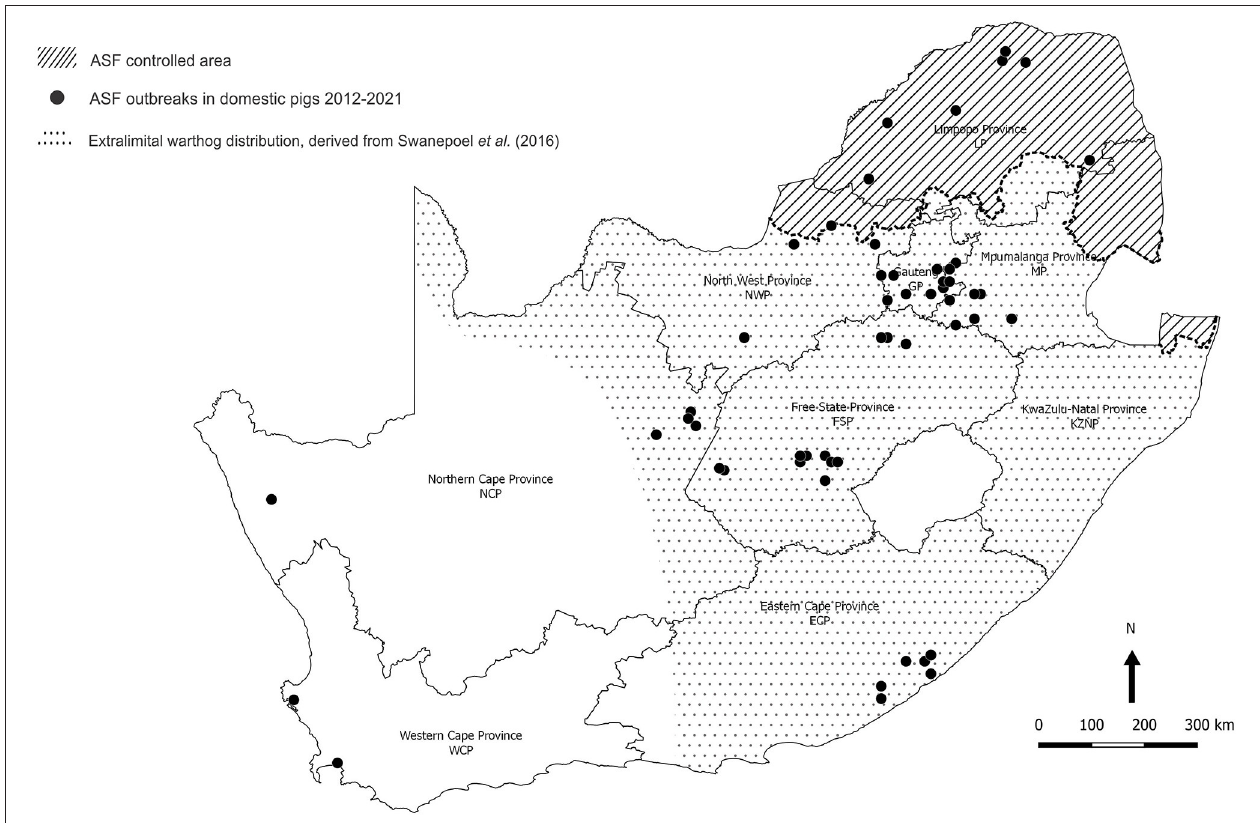
FIGURE 3 | Distribution of 85 outbreaks of African swine fever in South Africa, 2012–2020, for which approximate coordinates (correct to 0.1 degree) were derived from references cited in the text. The distribution of warthogs outside the controlled area was plotted with QGIS (Penn Libraries, Philadelphia, PA) using data from Swanepoel et al. (